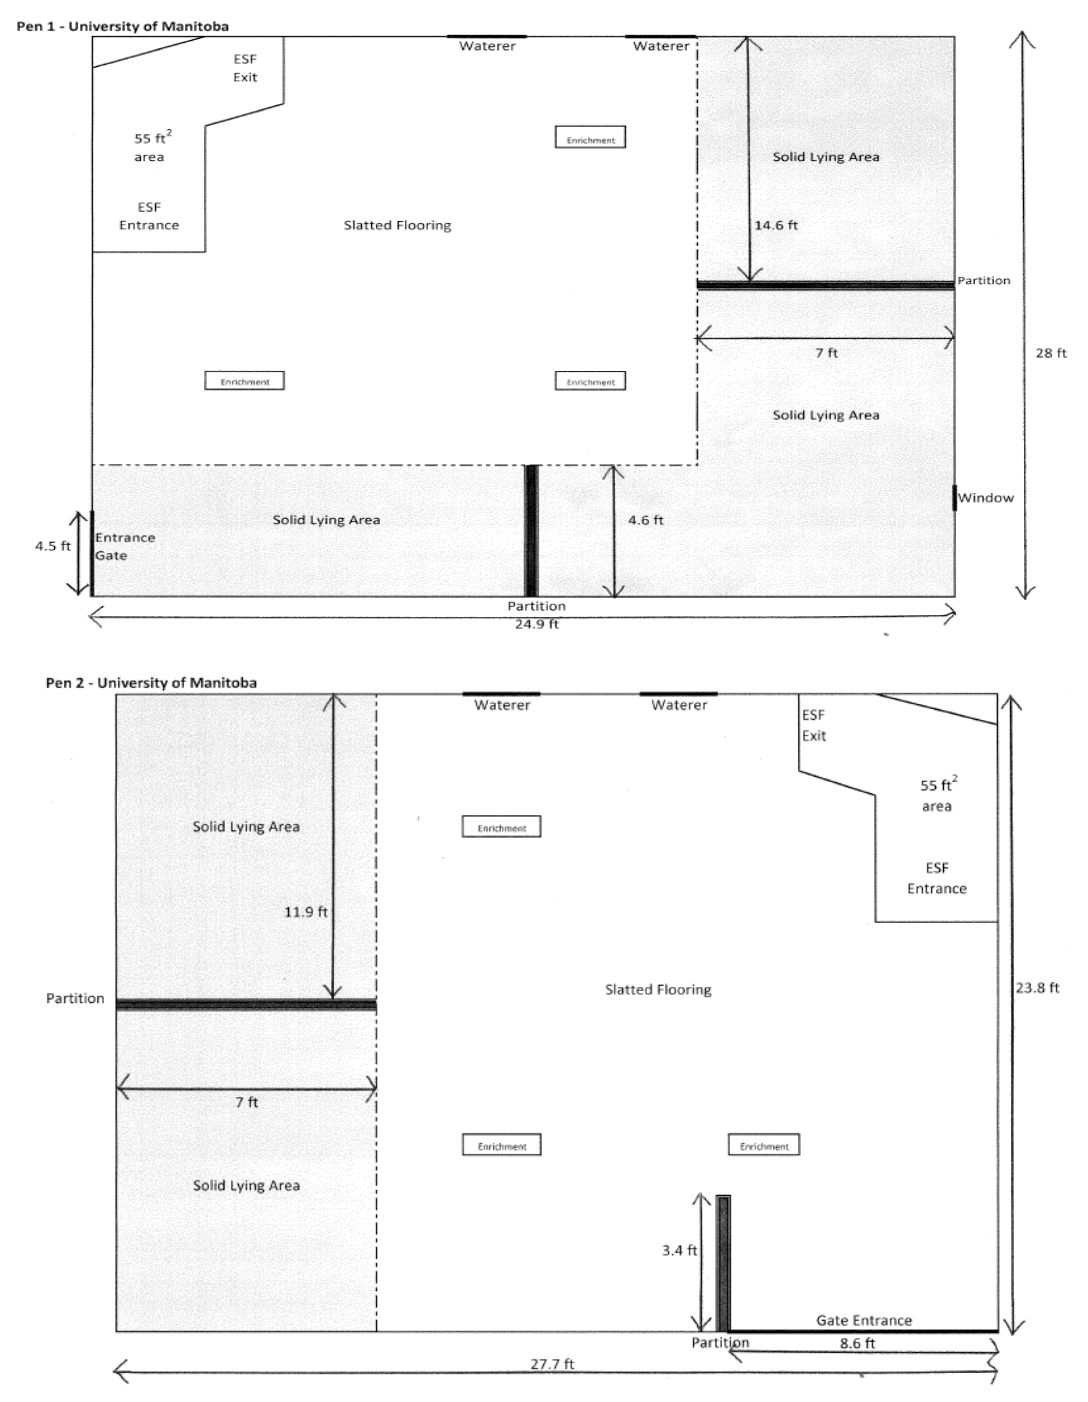
Figure 1. Pen designs used in the trial. Two of the pens had 43% solid floor area ( Pen 1 ) and two pens had 25% solid floor area ( Pen 2 ).